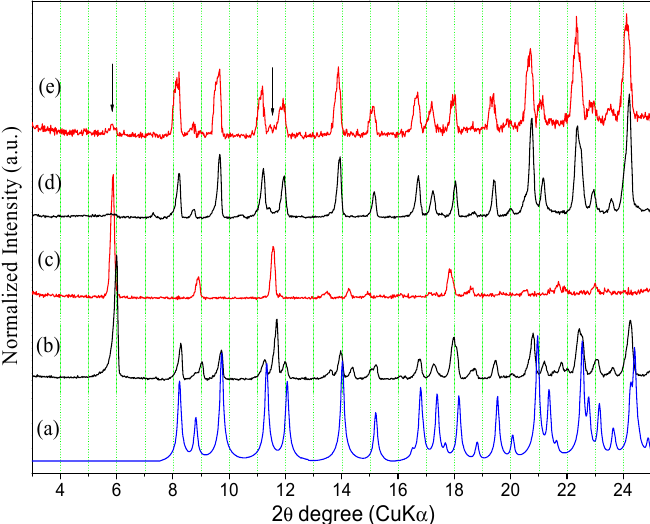
Figure 12. Calculated and experimental PXRD patterns of ORBI forms after the equilibrium solubility test: (a) ORBI hemihydrate form (calculated); (b) ORBI hemihydrate in 0.1 mol ∙ L − 1 HCl; (c) ORBI test: (a) ORBI hemihydrate form (calculated); (b) ORBI hemihydrate in 0.1 mol ¨ L ´ 1 HCl; (c) ORBI anhydrous in 0.1 mol ∙ L − 1 HCL; (d) ORBI hemihydrate in 0.01 mol ∙ L − 1 HCl (e) ORBI anhydrous in anhydrous in 0.1 mol ¨ L ´ 1 HCL; (d) ORBI hemihydrate in 0.01 mol ¨ L ´ 1 HCl (e) ORBI anhydrous in 0.01 mol ∙ L − 1 HCl. The extra Bragg peaks are shown by arrows. 0.01 mol ¨ L ´ 1 HCl. The extra Bragg peaks are shown by